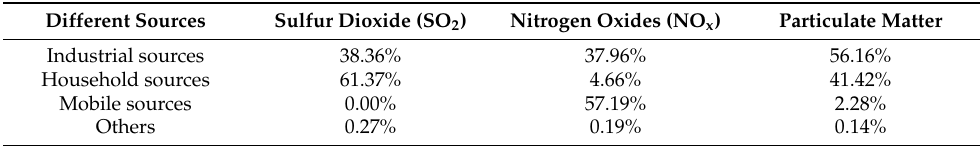
Table 1. The proportions of air pollutants from different sources in Wuhan. Different